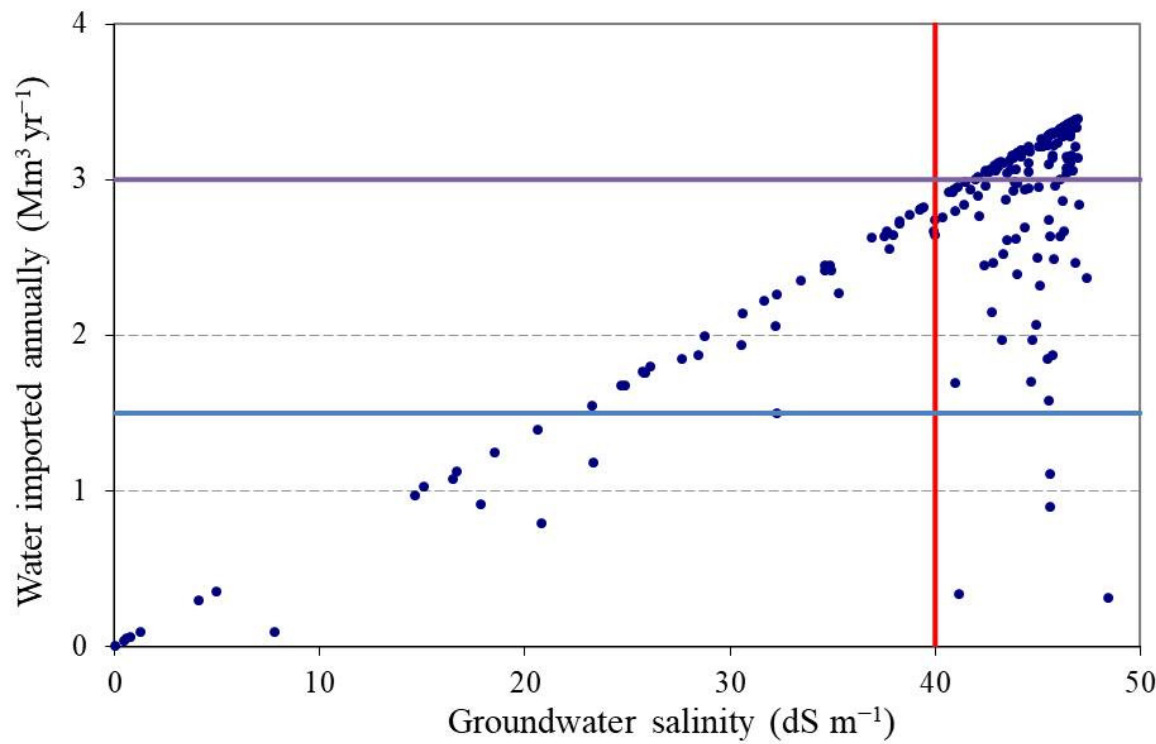
Figure 5. Cloud of the indicator end values after simulating 200 scenarios that combine different random values of the parameters “average rainfall recharge” and “revenue per hectare”. The red line indicates the degradation threshold considered for “Groundwater salinity” (40 dS m − 1 ). Blue and purple lines indicate the thresholds considered for “Water imported annually” (1.5 and 3 mm 3 yr − 1 ).